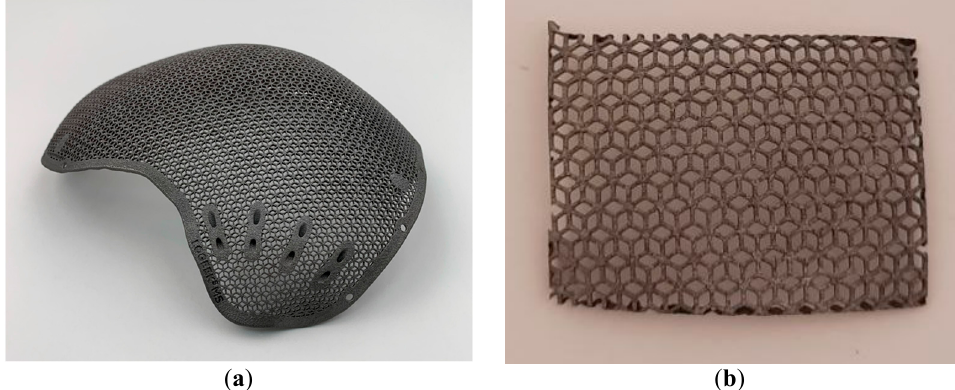
Figure 1. An implant for restoring the integrity and anatomical shape of the skull with a structure analogous to the mesh structure of the samples used in the present work ( a ). General view of a titanium plate of mesh structure, onto which the HA coating was deposited ( b ).